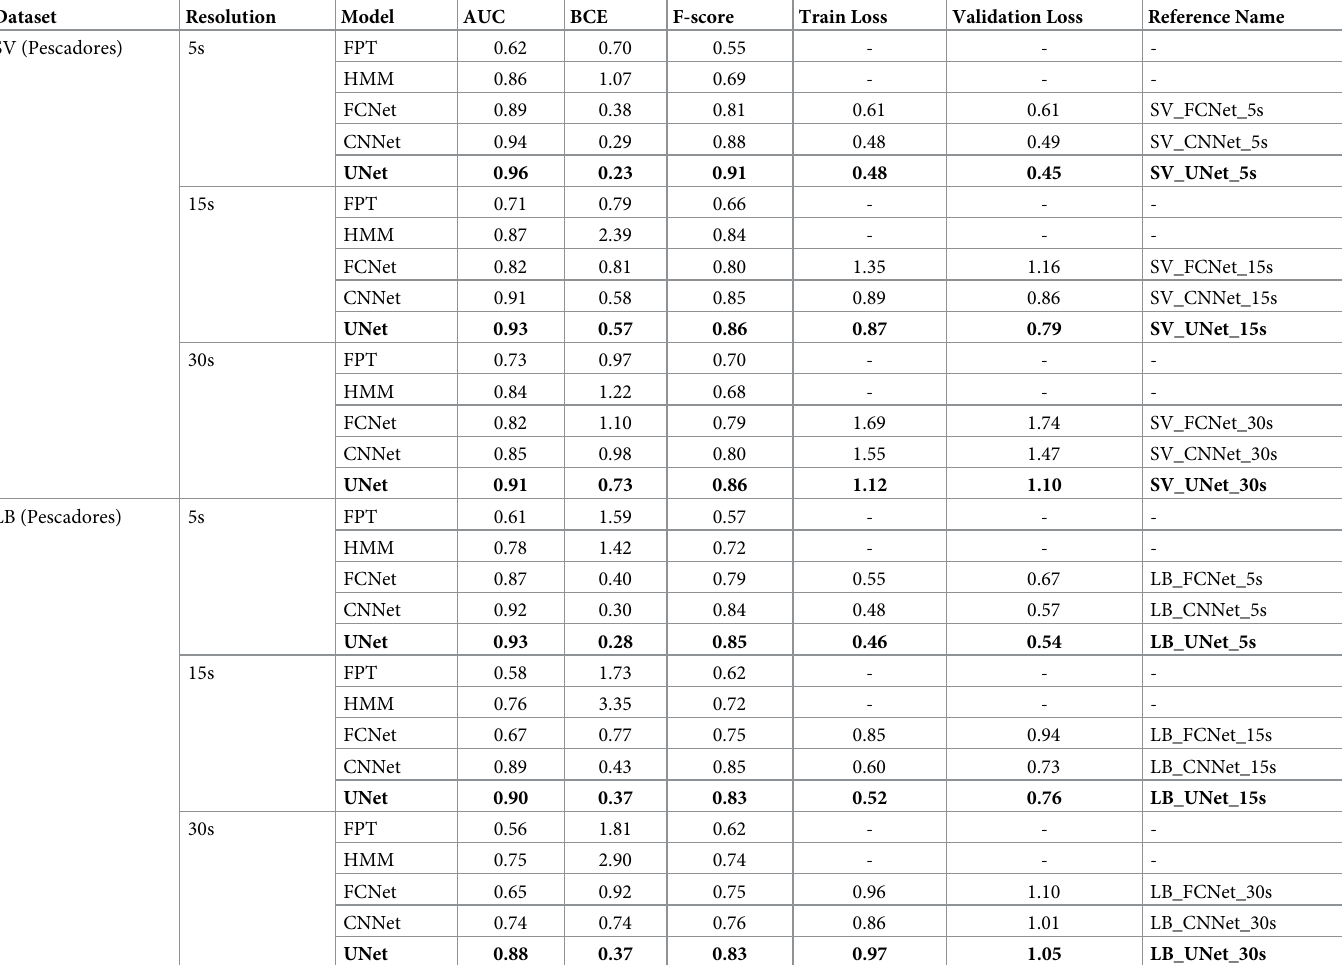
Table 2. Deep networks training. Performance metrics for all trained deep networks on the trajectories of Pescadores along with benchmarked methods used for comparison.